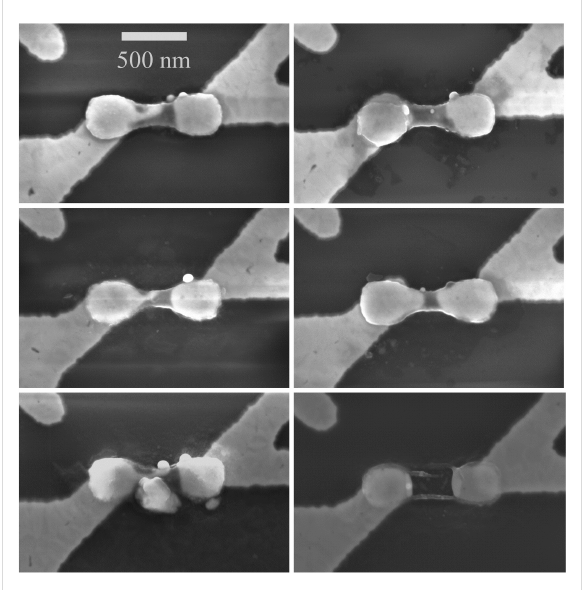
Figure 8: Representative SEM images of six physically broken cells with lost connections, showing significant variability in the void formation despite having similar dimension ( L GST ≈ 470 nm, W GST ≈ 130 nm, and t GST ≈ 50 nm) and being programmed to a simi- lar initial R programmed